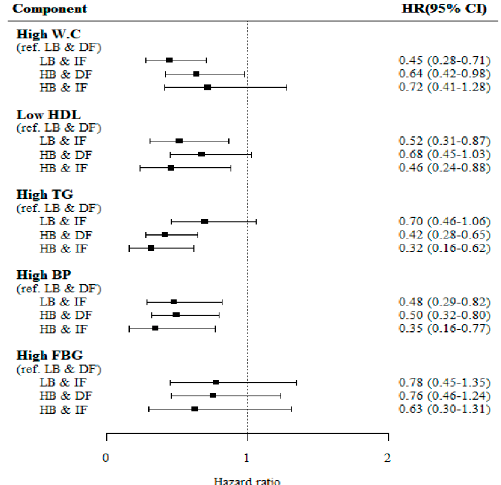
Figure 1. Association between adiponectin concentrations and incidence for each component of metabolic syndrome. Adjustment for age, sex, current smoking, regular exercise, alcohol intake, baseline body mass index, high sensitive C-reactive protein, low density protein lipoprotein cholesterol, HOMA-IR (log transformed), and follow-up body mass index. HR, hazard ratio; W.C, waist circumference; HDL, high density lipoprotein cholesterol; TG, triglyceride; BP, blood pressure; FBG, fasting blood glucose; LB&DF, low adiponectin at baseline and decreased adiponectin during follow-up; LB&IF, low adiponectin at baseline and increased adiponectin during follow-up; HB&DF, high Figure 2. Association between adiponectin concentrations and incidence of each component of adiponectin at baseline and decreased adiponectin during follow-up; HB&IF, high adiponectin at metabolic syndrome stratified by sex (men (A) and women (B)). baseline and increased adiponectin during follow-up.